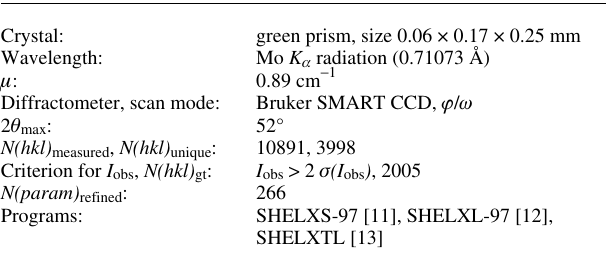
Table 1. Data collection and